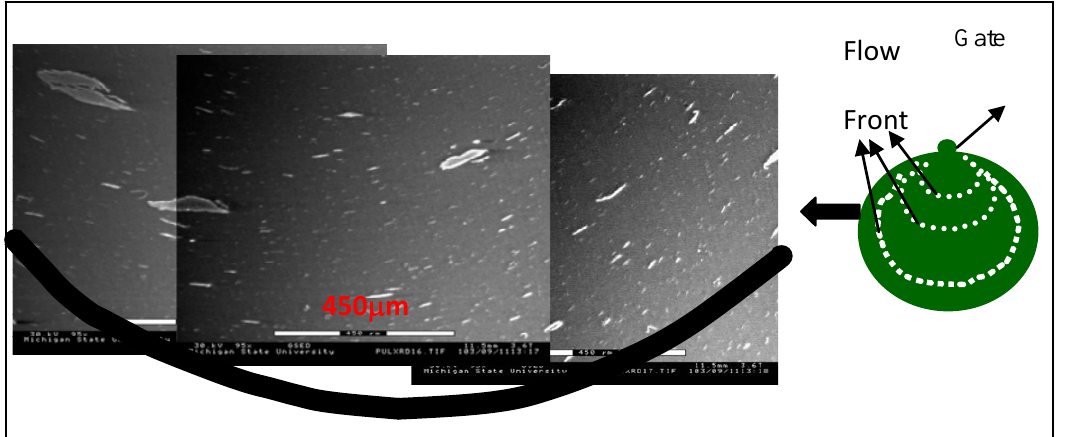
Figure 7. Orientation of xGnP in a disk shape xGnP-15/PP, (a) ESEM image (scale